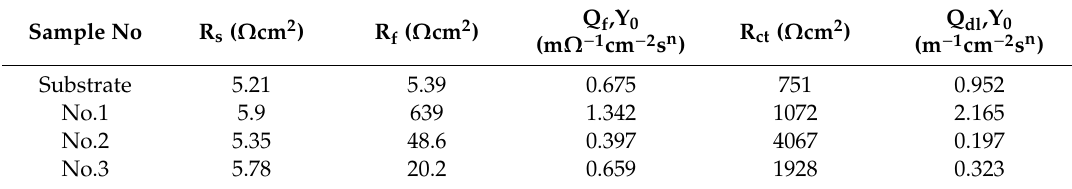
Table 4. Fitted values of the equivalent circuit of the electrochemical impedance spectra (EIS) diagram.